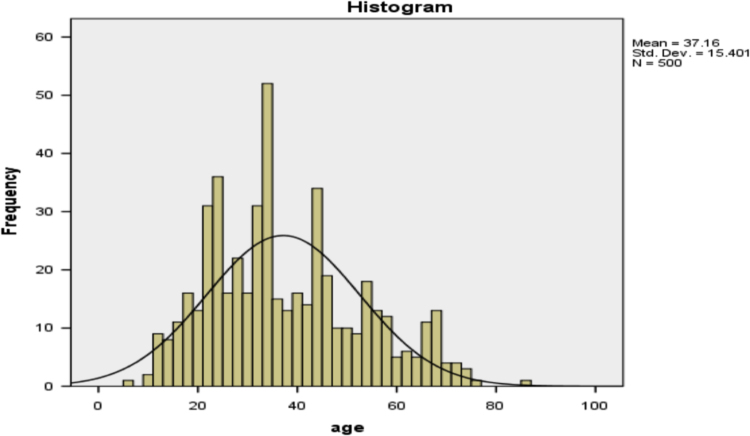
Histogram of age distribution of psychotic disorder patients in Yaba psychiatry hospital between 2010 and 2014.